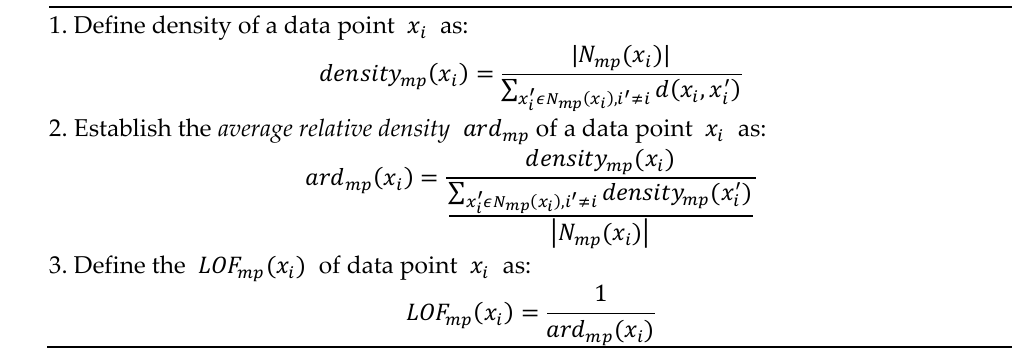
Figure 3. Formal definition of the Local Outlier Factor ( 𝐿𝑂𝐹 ) of a data point.